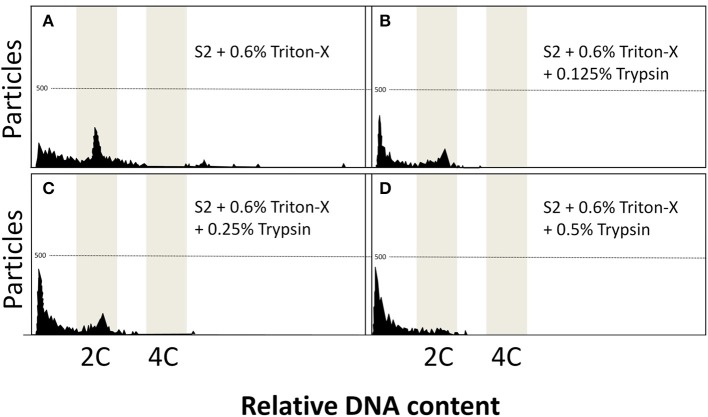
Flow cytometric charts of fin samples using various lysing treatments and staining with DAPI. Solution S2 was combined with three detergents (Triton-X, Tween-20, and Nonidet P-40 at 0.15, 0.3, 0.6, and 1.2%). Trypsin additions at 0.125, 0.25, and 0.5% was also evaluated. Triton-X at 0.6% gave some noisy peaks (A). Trypsin additions produced reduced peaks (B–D).